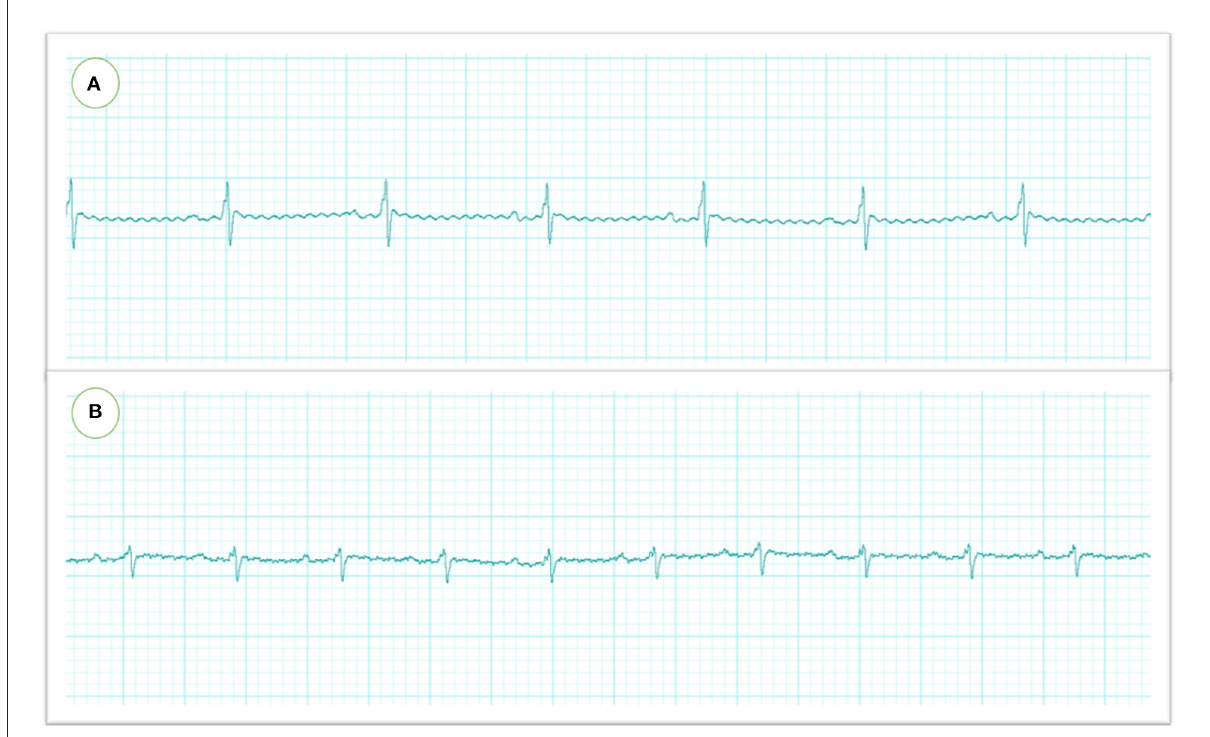
FIGURE2 Electrocardiographic recordings in rats were measured by needle electrodes with Lab chart. The heart rate and RR intervals were significantly reduced after MMB injection (before atipamezole administration) (A) which were restored to the normal level after atipamezole administration (B)